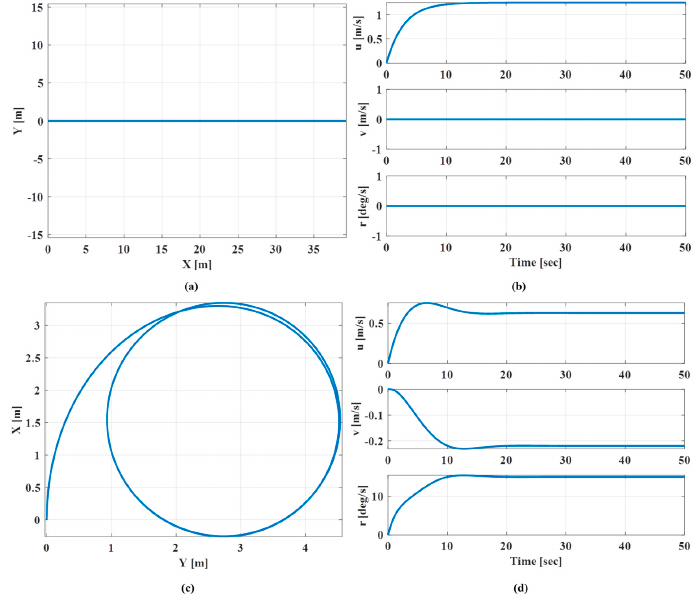
Figure 13. Simulation result of dynamics behavior of the USV according to straight and turning motion: ( a ) X - Y trajectory of the USV (straight motion); ( b ) Linear and angular velocity of the USV (straight motion); ( c ) X - Y trajectory of the USV (turning motion); ( d ) Linear and angular velocity of the USV (turning motion). 4.2. Case 2: Dynamic Behavior of the USV with Disturbance (Wind Load, Current)